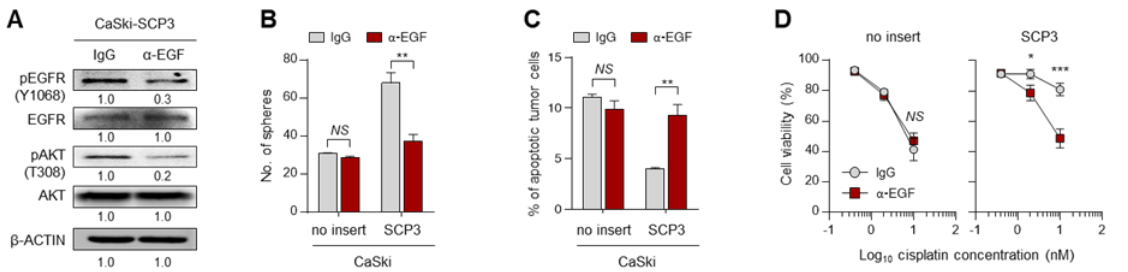
Figure 3. The EGF-EGFR axis plays a crucial role in SCP3-mediated multi-aggressive phenotypes. ( A – D ) CaSki-no insert or CaSki-SCP3 cells were treated with IgG or EGF antibody. ( A ) Western blot analysis of pEGFR, EGFR, pAKT, and AKT levels. β-ACTIN was used as an internal loading control. ( B ) Sphere-forming capacity of indicated cells. ( C ) Flow cytometry analysis of active caspase-3 + cells in the cells after intracellular delivery of granzyme B. ( D ) Cell viability was measured by live cell counting using trypan blue. All experiments were performed in triplicate. The p -values were determined by unpaired, two-tailed Student’s t -test. The data represent the mean ± SD (* p ≤ 0.05, ** p ≤ 0.01, *** p ≤ 0.001. NS , not significant).